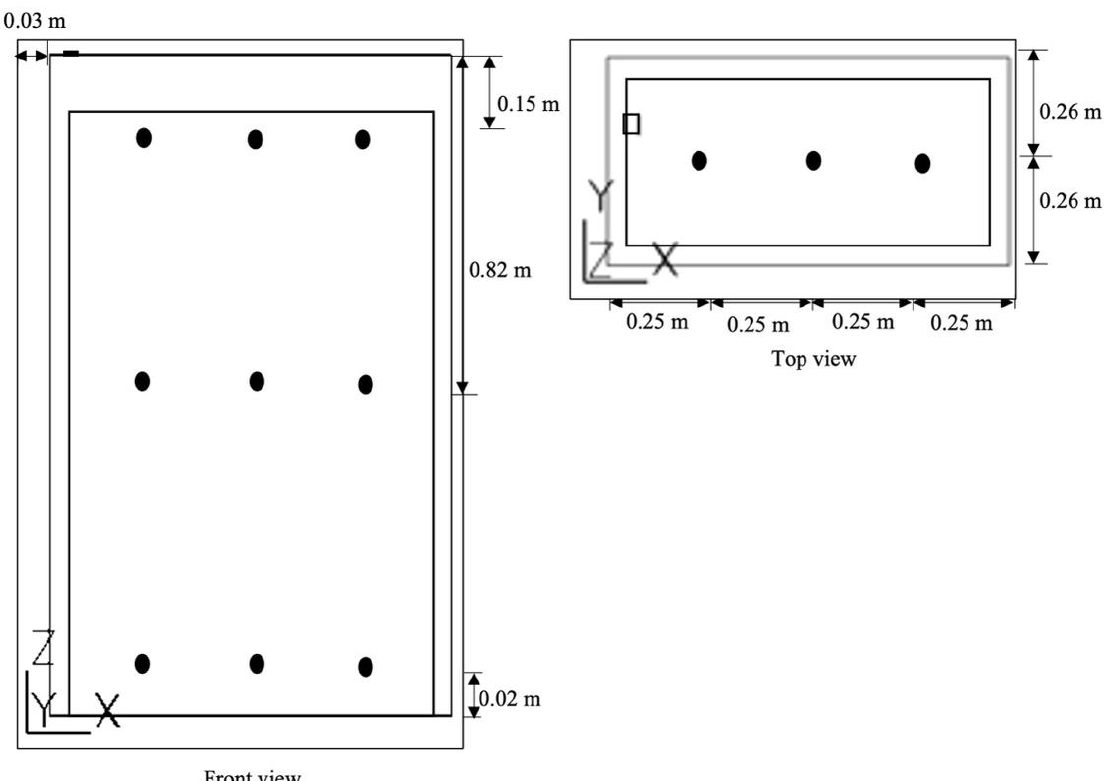
• ) at the front ( left ) and top ( right